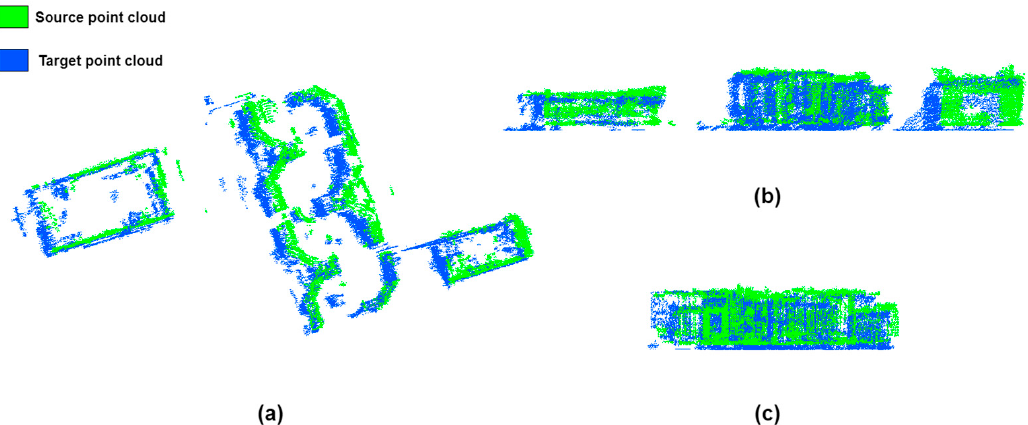
Figure 7. The source and target point clouds after coarse alignment and rotation correction are shown in green and blue: ( a ) point cloud of the top view; ( b ) point cloud of the side view; ( c ) point cloud of the front view.